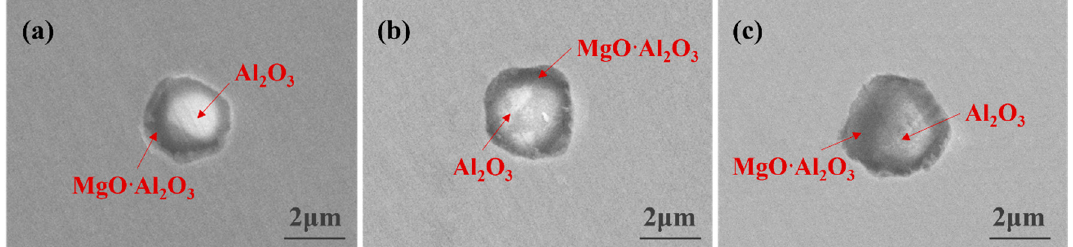
Figure 2. The composition distribution diagram of the inclusions in the sample. ( a ) sample M1, ( b ) sample M2, ( c ) sample M2.